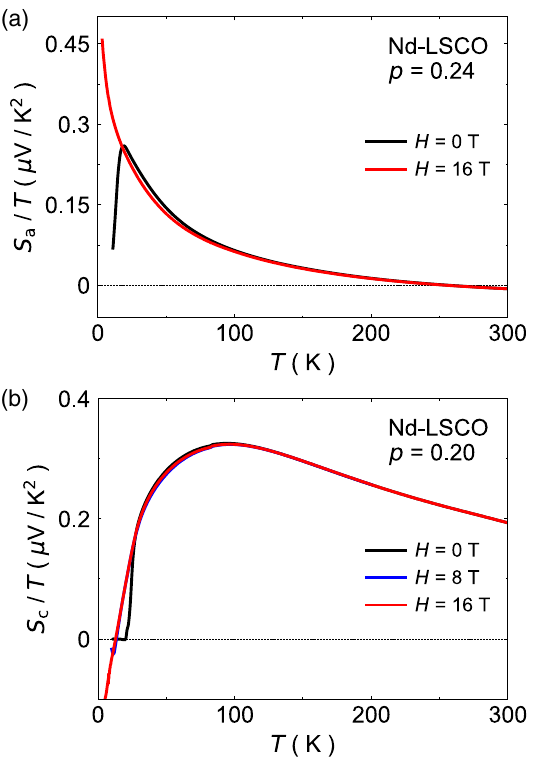
FIG. 5. S=T of Nd-LSCO as a function of the temperature for different fields applied parallel to the c axis. (a) S a =T at p ¼ 0 . 24 in H ¼ 0 and 16 T. (b) S c =T at p ¼ 0 . 20 in H ¼ 0 , 8, and 16 T. We see that applying a field has very little effect on the normal- state S c =T curve, except for suppressing superconductivity and revealing it down to low